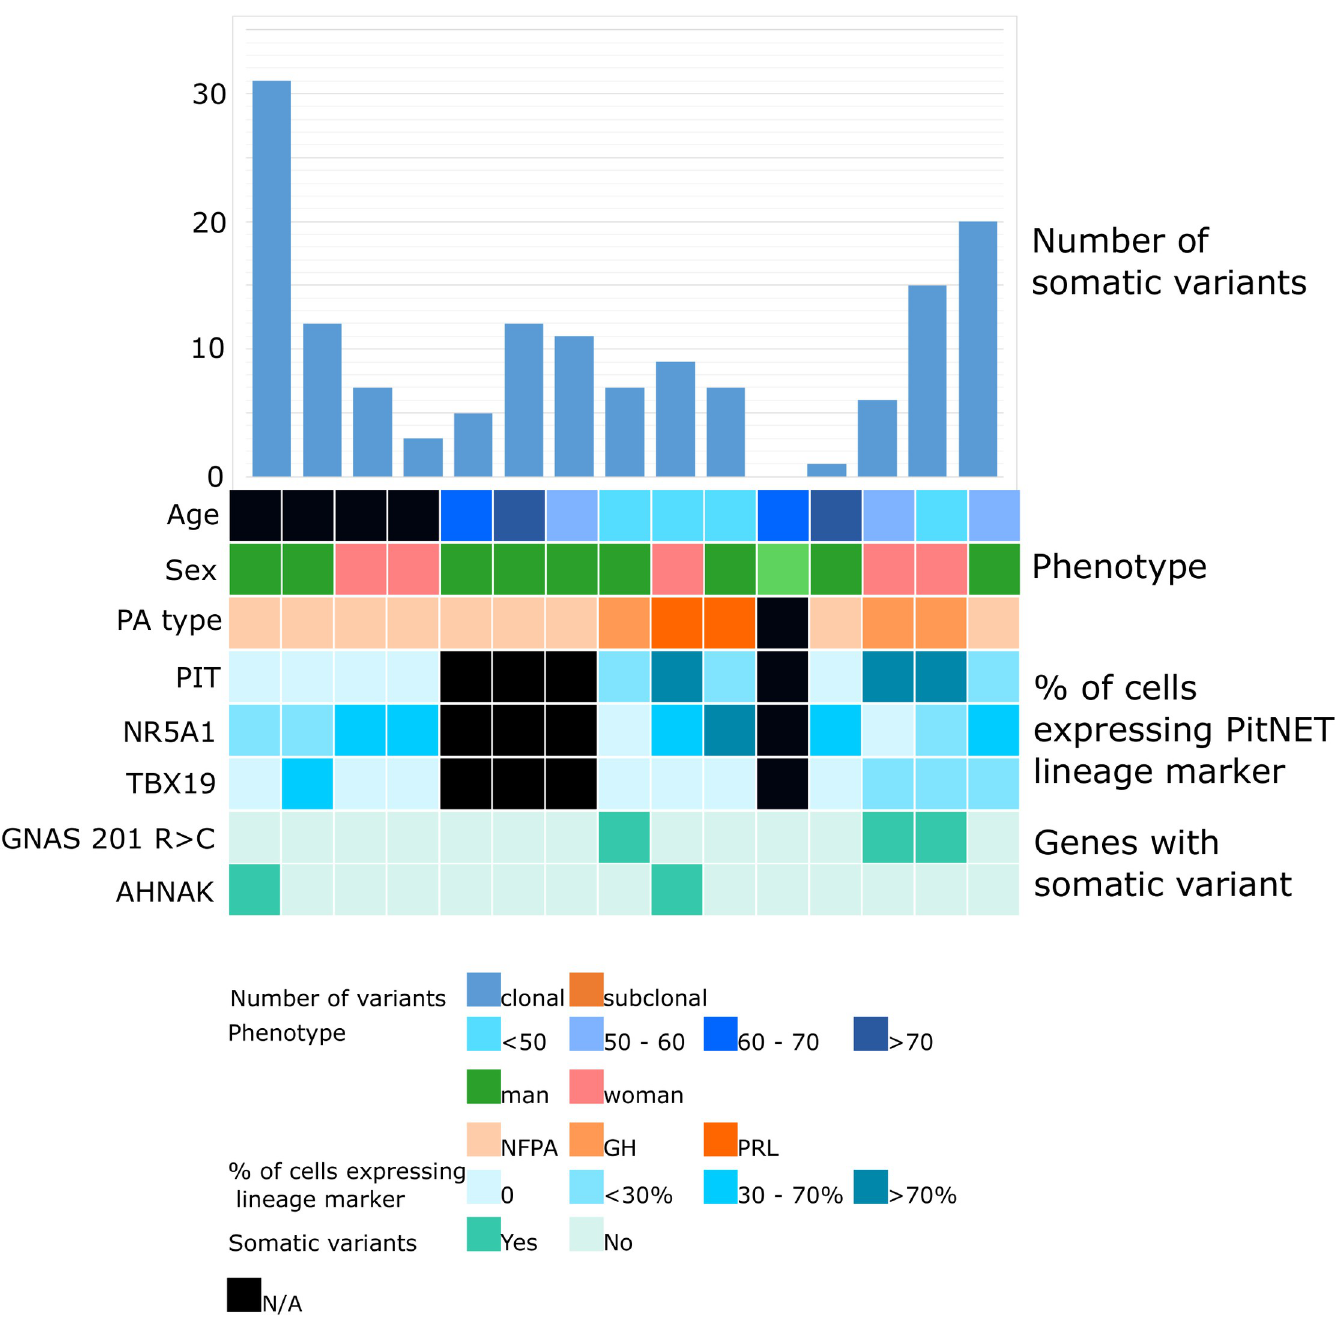
Fig 1. Amount of somatic variants, clinical information of PitNET patients (PitNET clinical type, age at diagnosis, sex), % of cells expressing lineage markers and genes with recurrent somatic variants are shown for all 15 PitNET patients. PitNETs are listed in ascending order from left to right.